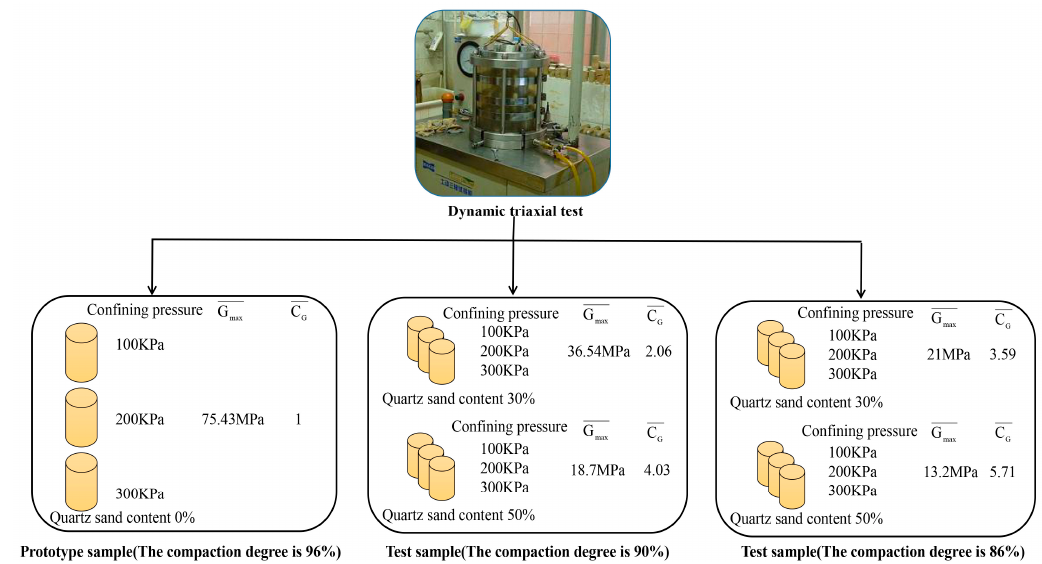
Figure 3. Design of dynamic triaxial tests and test results.